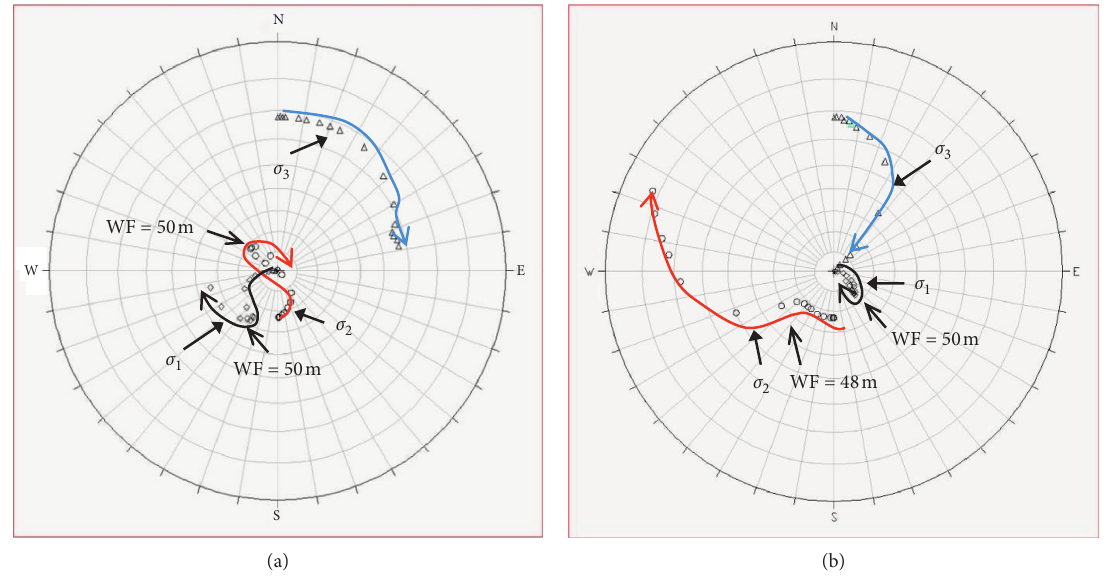
Figure 6: Pole diagrams of principal stress axes of monitoring points as the tunnel face approaches from WF � 0 to WF � 60m. (a) Monitoring point A of the tunnel roof. (b) Monitoring point B of the tunnel wall.